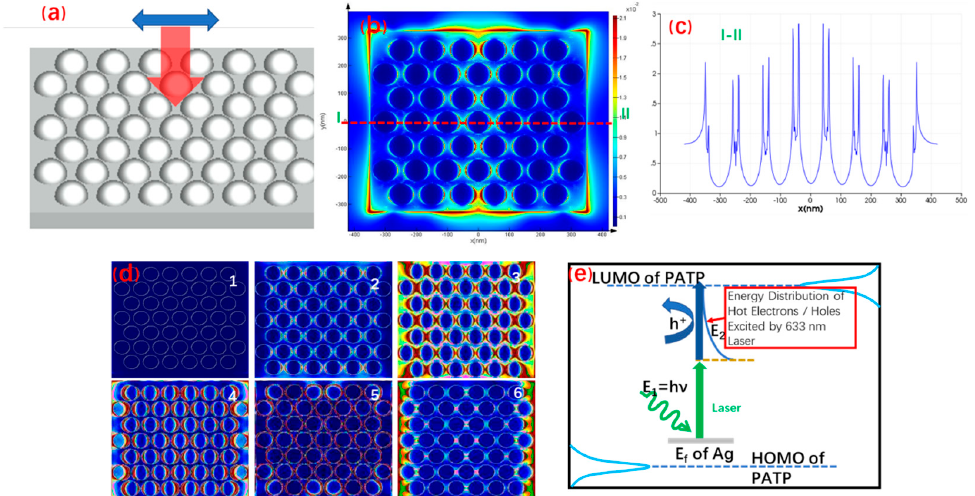
Figure 4. The mechanism of spherical silver nanoarrays plasma driven photocatalysis including: ( a ) the theoretical model and polarization direction of the stimulated luminescence simulated by the surface plasmon; ( b ) calculation results of the intensity distribution characteristics of the surface plasmon of the spherical silver nanoarrays; ( c ) analysis of intensity distribution simulated by the surface plasmon of the spherical silver nanoarrays; ( d ) surface plasmon distribution of the spherical silver nanoarrays; and ( e ) the mechanism of the spherical silver nanoarrays plasma-driven photocatalysis.